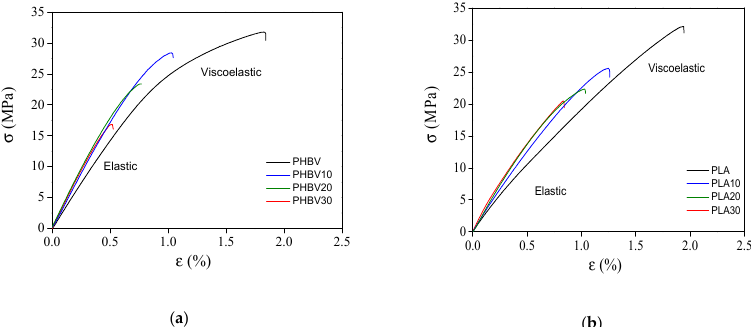
Figure 3. Stress-strain plots for poly (3-hydroxybutyrate- co -3-hydroxyvalerate (PHBV) ( a ) and polylactide acid (PLA) ( b ) biocomposites.